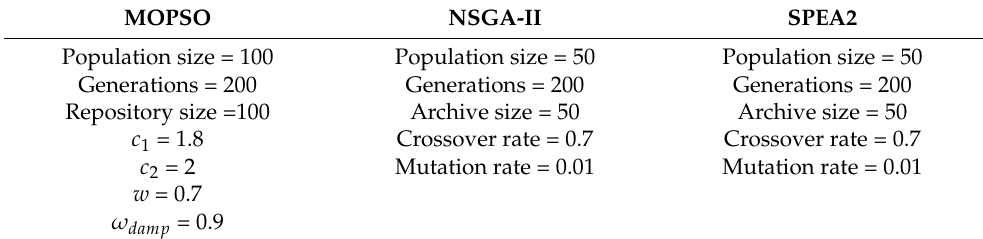
Table 6. Multi-objective optimization algorithm parameters.